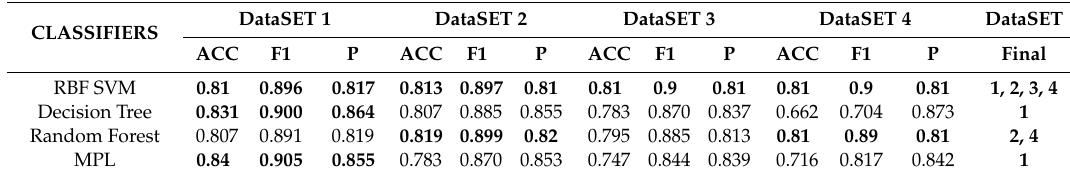
Table 5. Comparison of results.